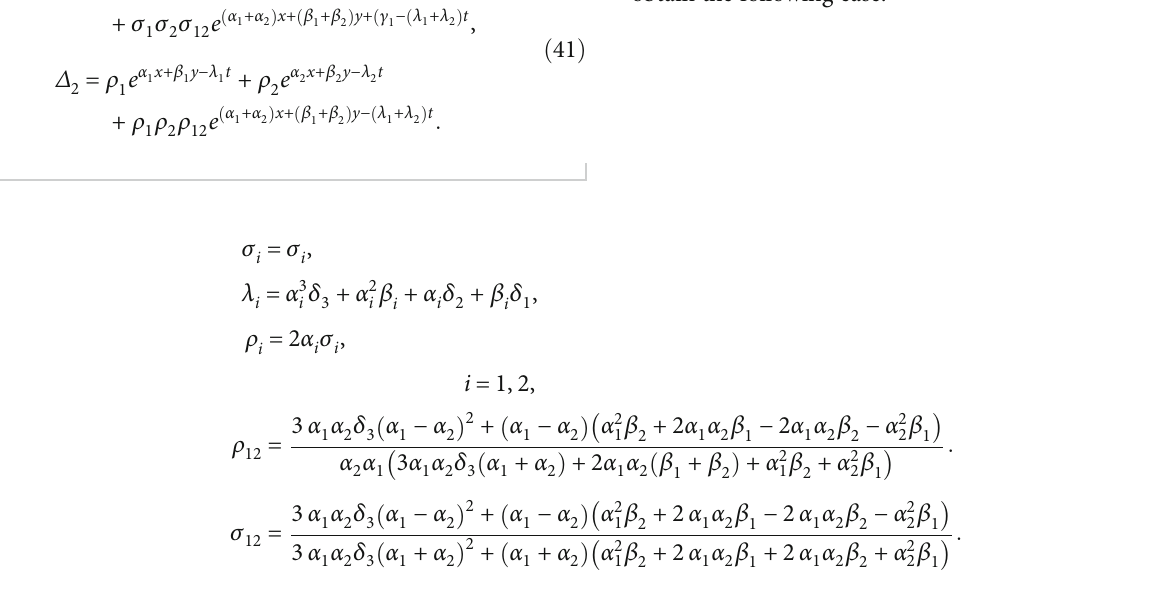
= 3, ρ = 2, β = 1 : 5, δ 2 1 1